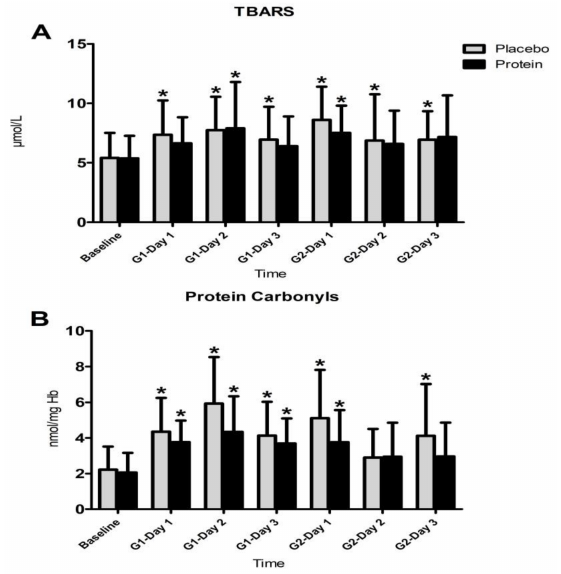
Figure 5. Changes in TBARS ( A ) and protein carbonyls ( B ). TBARS, thiobarbituric acid reactive substances; G1, game 1; G2, game 2; * denotes a significant difference with baseline at p <